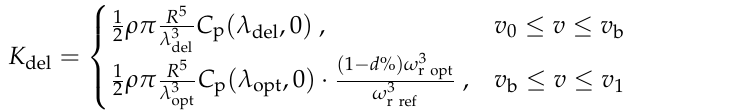
Figure 4. When receiving deloading signals from the system operator, the control center broadcasts the deloading order, d %, and wind speed boundary, v b , to all the WTGs. Then, WTGs in low wind speed adjust the DPPT coefficients, K del , according to (13), and they accomplish the deloading task through the OSC. For the WTGs in high wind speed, the PAC and the OSC are both applied to deload. The corresponding K del can be calculated from (13), and the deloading pitch angle is obtained through the β 0 table.